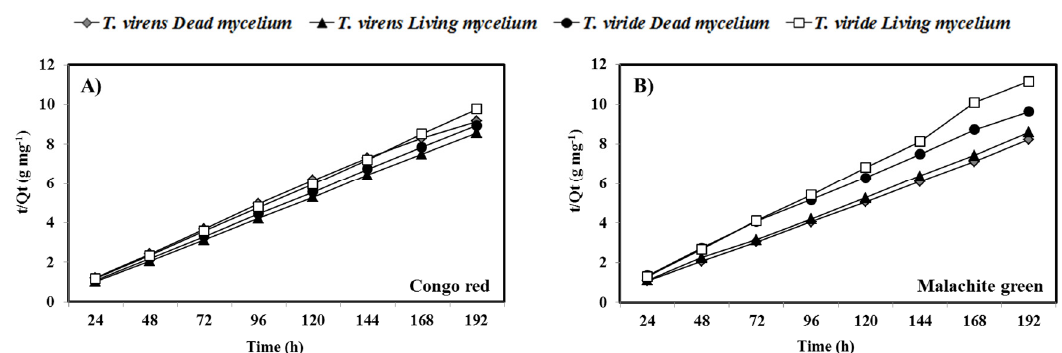
Figure 3. Pseudo-second-order model plot for fungal fresh biomass. ( A ) Congo red and ( B ) malachite green. Lines are guides to the eyes.